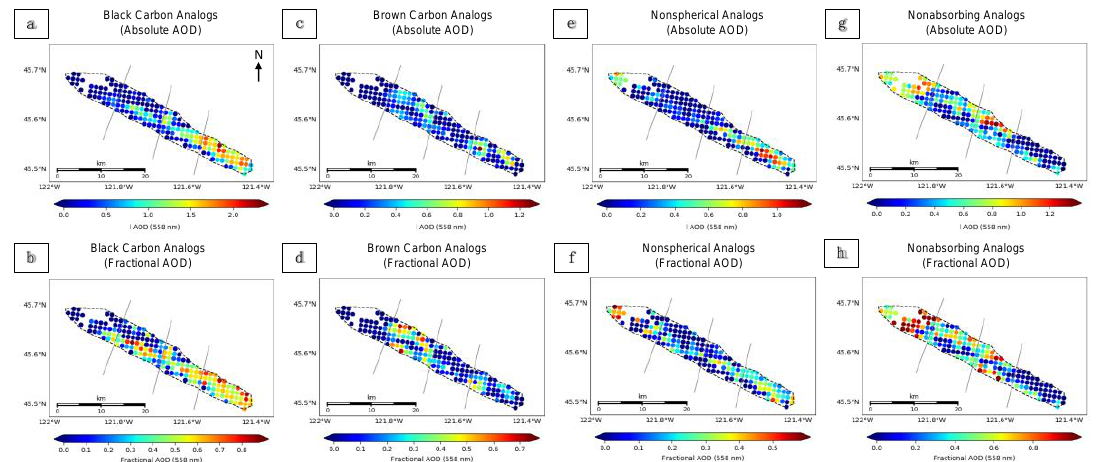
Figure 4. Plume properties for the Government Flats Complex Fire retrieved by MISR at 19:07 UTC (Orbit 72746, Path 45, Block 54) on 21 August 2013: (a) MISR Interactive Explorer (MINX) stereo height retrieval map; (b) MINX stereo height profile as a function of distance from the source, for both zero- wind (red) and wind-corrected (blue) analyses, with surface elevation indicated in green, (c) MINX- retrieved across-swath and along-swath wind vectors, and RA-derived (d ) AOD at 558 nm, (e) extinction ANG, and (f) SSA at 558 nm. The transects for estimated plume ages corresponding to the regional boundaries in Figure 1 are indicated with thin gray lines in panels d–f.